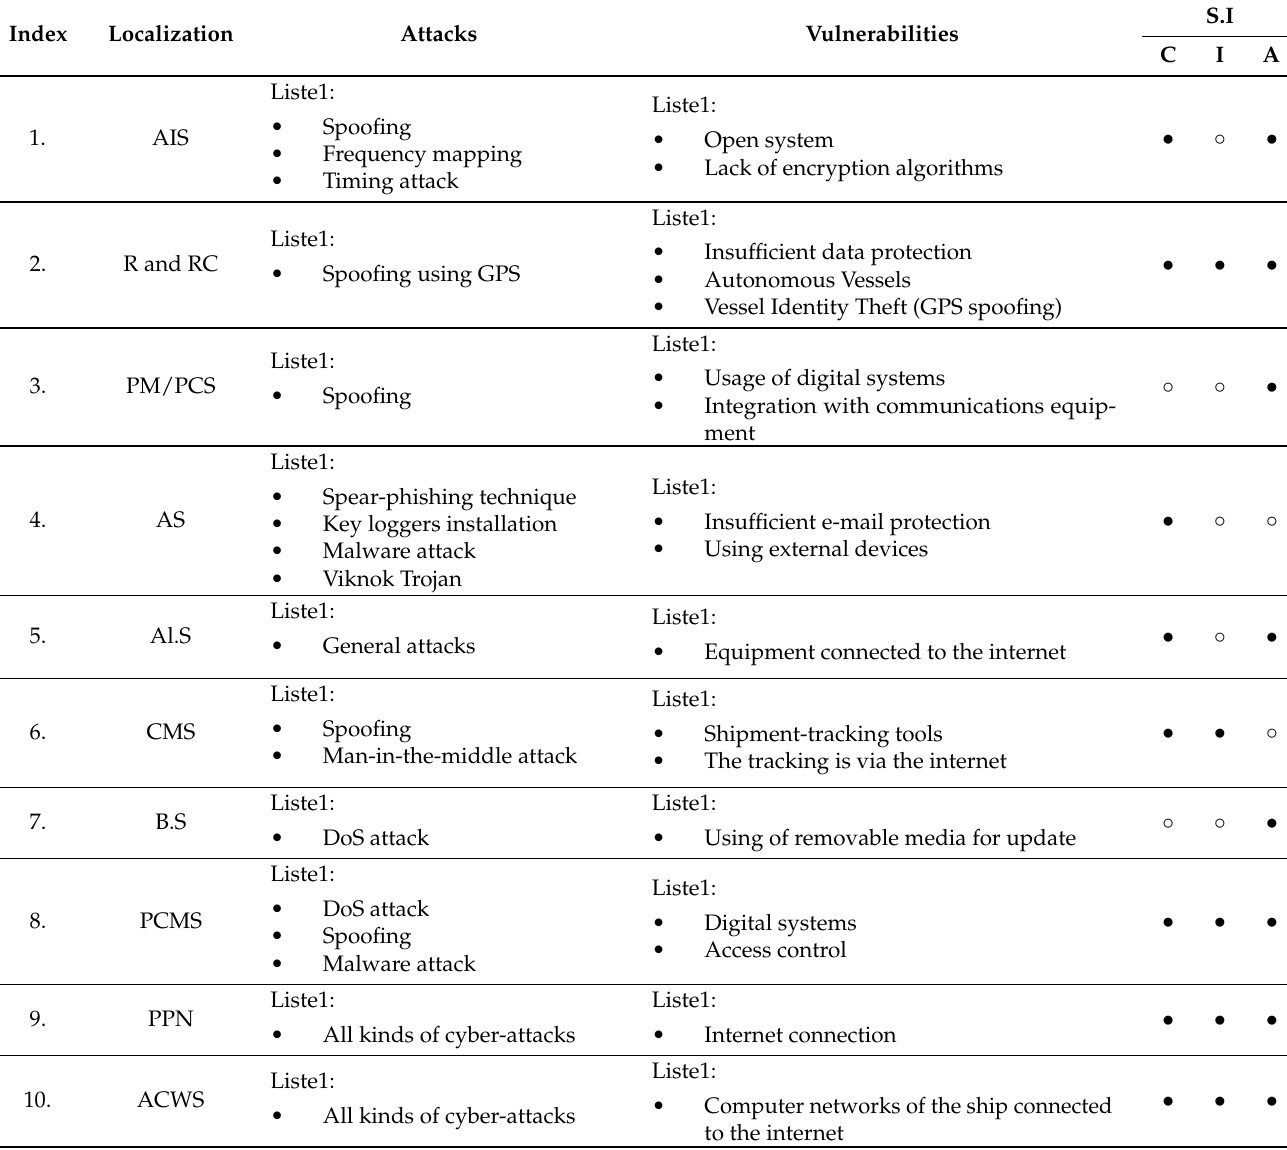
Table 5. Attacks classification and security